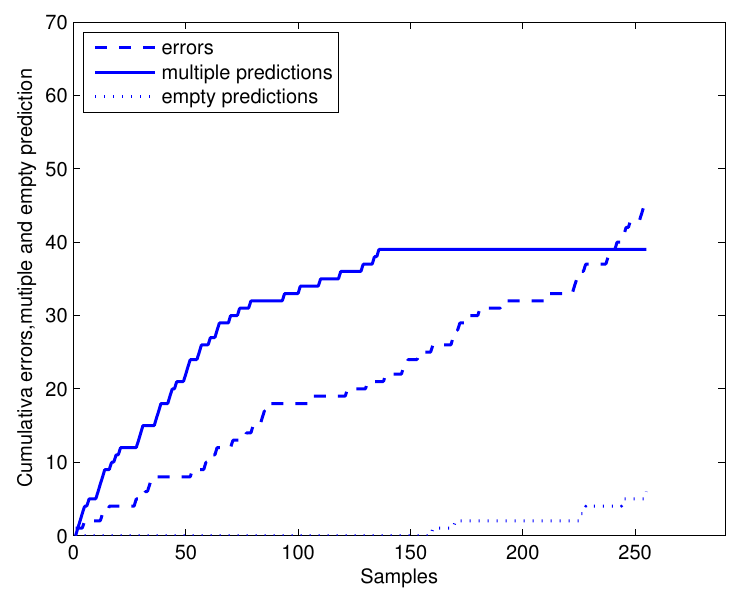
Figure 4. Online conformal prediction with confidence level of 80%.